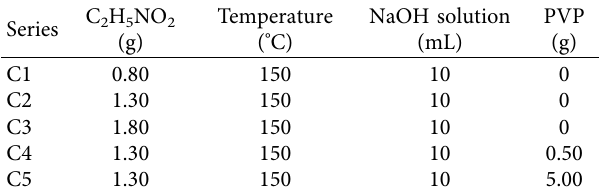
Table 1: Synthesis conditions of the Cu